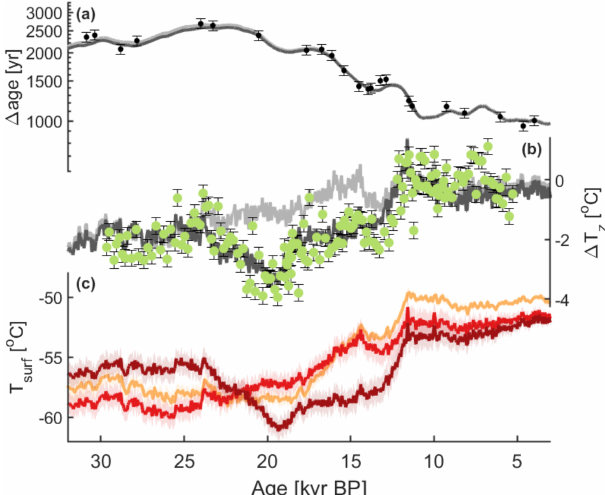
Figure 4. (a) Modeled (cid:49) age at SPICEcore in the REF (light grey) and DECOUPLE (dark grey) experiments. Markers show empirical (cid:49) age data from Epifanio et al. (2020). (b) SPICEcore (cid:49)T z recon- struction (green points), together with the modeled (cid:49)T z from the REF (light grey line) and DECOUPLE (dark grey line) model ex- periments. (c) South Pole surface temperature reconstructions from the REF (light red) and DECOUPLE (dark red) model experiments. Shading shows 1 σ model uncertainty from Buizert et al. (2021). Also shown is a temperature reconstruction from Kahle et al. (2021) (orange), based on a calibration of δ 18 O ice using (cid:49) age and the wa- ter isotope diffusion length proxy. Shading shows 1 σ standard de- viation of model ensemble